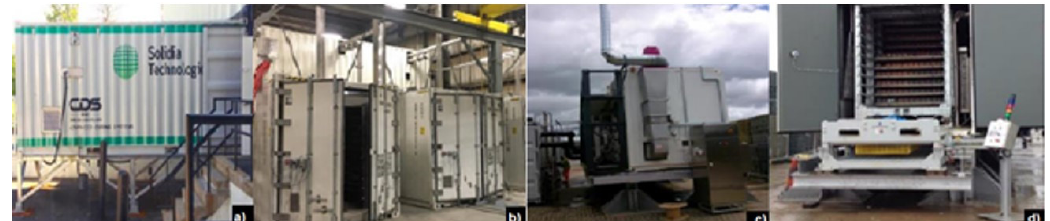
Figure 4. Carbonation chambers developed in Container structures, located: a) USA, b) Canada, c) d) UK. Source: